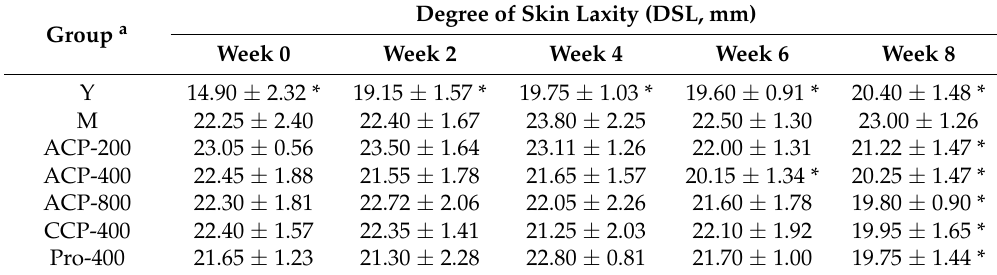
Table 2. Degree of skin laxity (DSL) of chronologically aged mice after the administration of collagen peptides for 8 weeks.